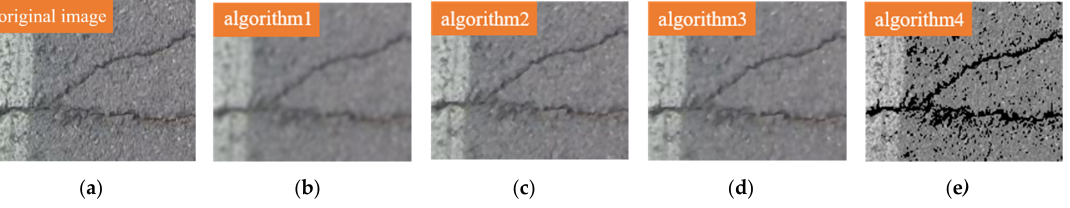
Figure 8. Original image and sparse feature image: ( a ) original image, ( b ) algorithm1, ( c ) algorithm2, ( d ) algorithm3, ( e ) algorithm4.